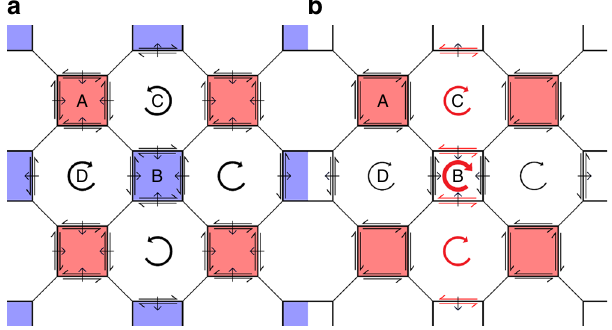
Fig. 10 Idealized Microstructure Predicted and Observed Behavior. a Predicted shear-coupling sense (arrows parallel to each GB), stress (grain shading), and rotation (circular arrows) according to bicrystal simulations for the idealized microstructure. b Same as in a but based on the actual microstructure evolution simulations (Fig. 4). Red arrows denote behavior in b that contradicts the predictions in a . Red and blue shading denote shear stress of